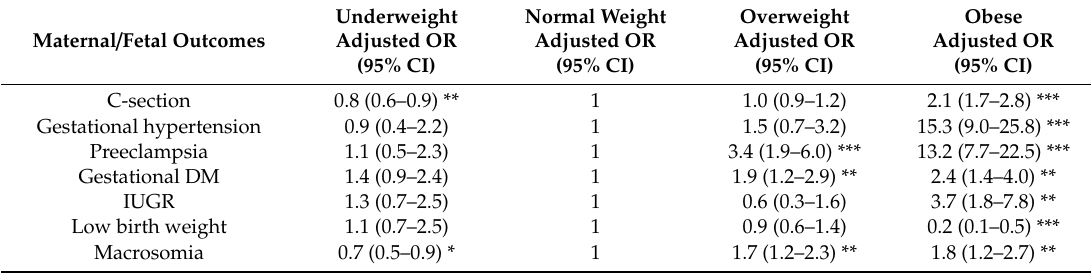
Table 2. The relations among weight categories and selected maternal / fetal outcomes (multivariable logistic regression analysis).